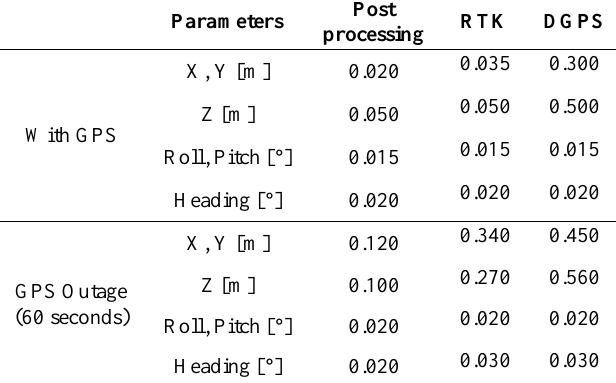
Table 7. Accuracy of the reference